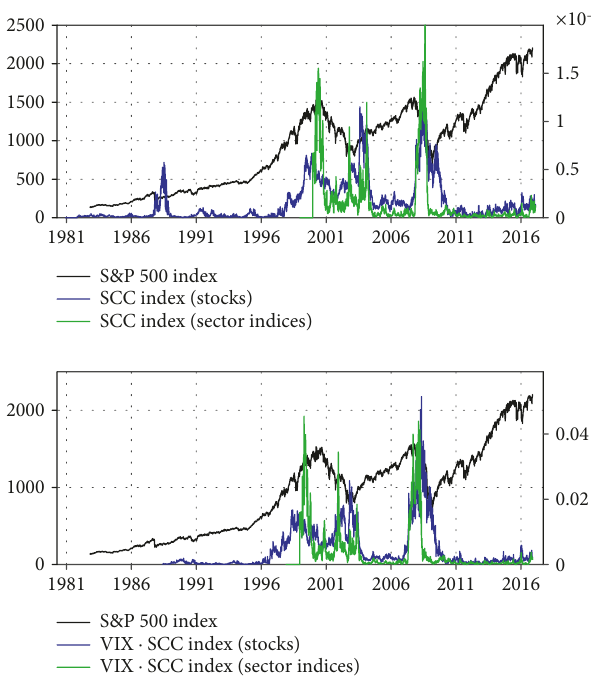
Figure 7: The estimated SCC index and the product of the VIX index and the SCC index as early-warning indicators for fi nancial crises, shown with the S&P 500 market index as a benchmark of the U.S. stock market performance. The sector index data is only available since 2000 (green lines), and the VIX data is available since 1990, thus the VIX · S on the lower graph is only displayed from that point on — the time frames are nevertheless kept the same on both graphs for